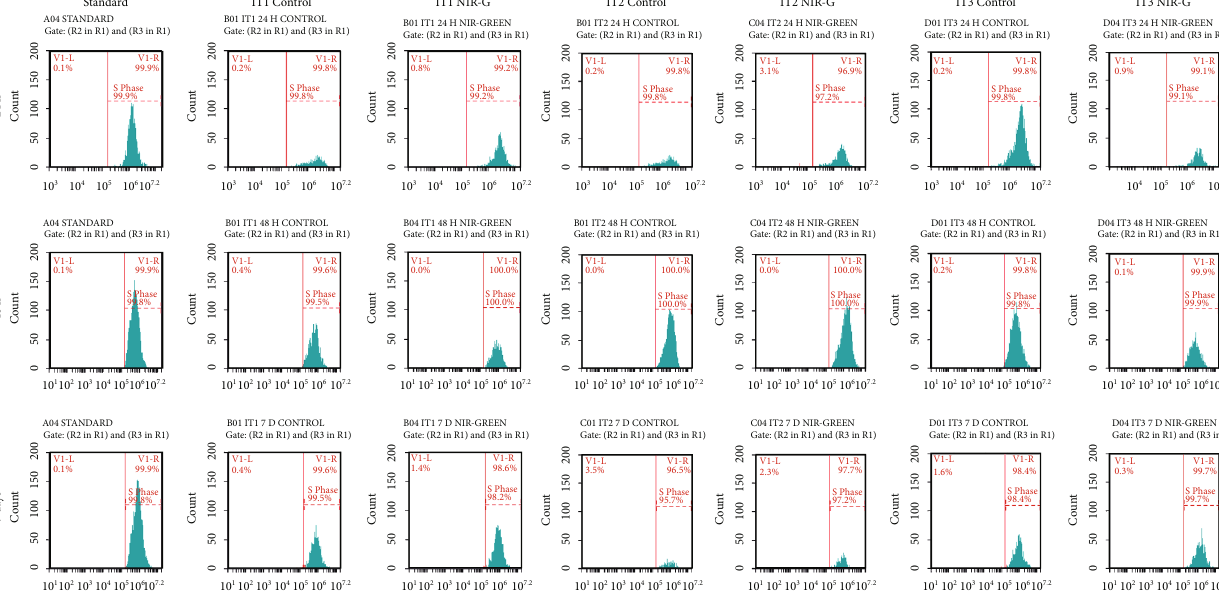
Figure 9: EdU results of IT3 transdi ff erentiating iADSCs 24 h, 48h, and 7 days post-PBM. S phase distribution using EdU base-click analysis. A shift to the right in distribution indicated an increase in EdU